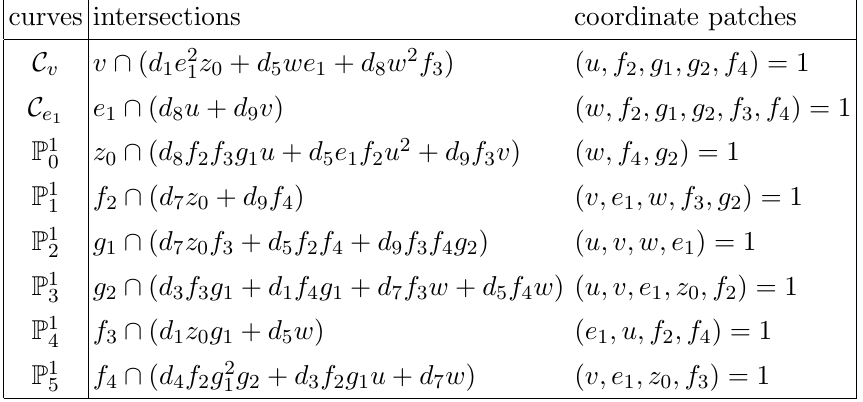
Table 5 . Curves on the CY twofold Y 2 de(cid:12)ned as intersections of divisors with Y 2 . On each divisor the coordinates enclosed in ( : : : ) can be set to one by C (cid:3) -actions.